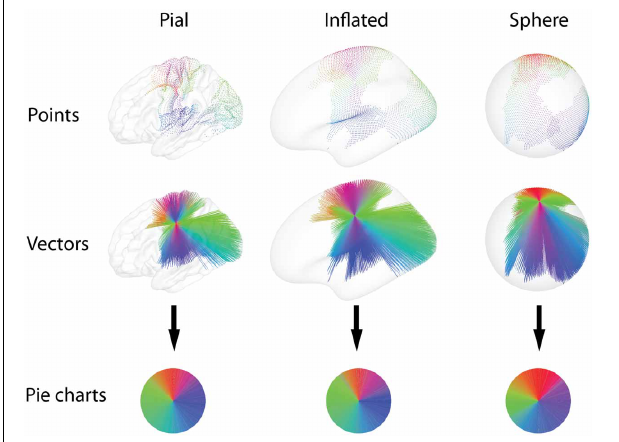
FIGURE 3 | Functional connectivity is calculated between each pair of nodes on a set of cortical surface representations, and thresholding yields a set of connections, here colored by orientation. The colors and geometry of the connections are then used to calculate diverse glyph representations of the connectivity profile at each node. The vector and point glyph geometry is influenced by the choice of surface on a spectrum from the anatomically determined pial geometry, to the spherical representation. Drawing points diminishes overdraw, while drawing vectors emphasizes long-range connections. After sorting the colors by their hue, the pie charts emphasize the ratio of connections with different orientations.